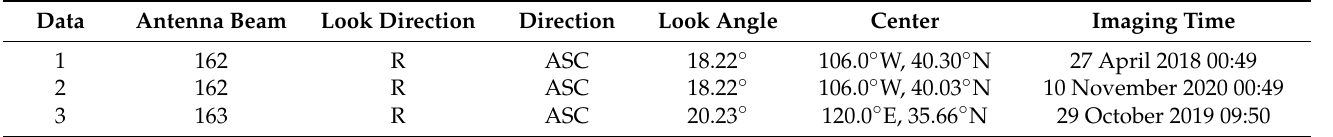
Table 3. GF-3 radar parameters.